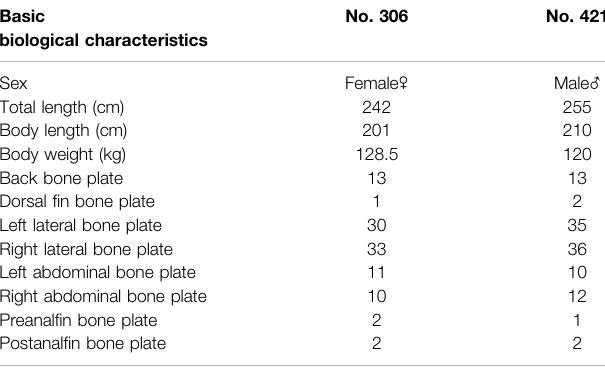
TABLE 1 | Basic biological characteristics of the two Chinese sturgeons under study. Basic biological